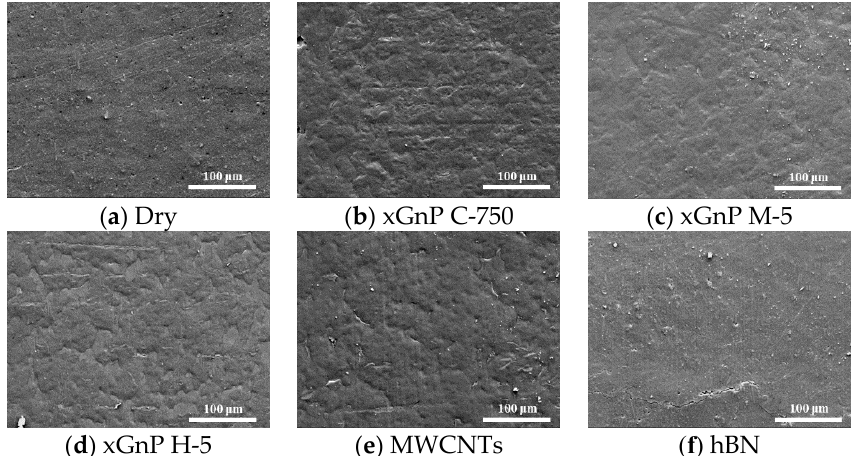
Figure 5. Optical microscopic images of MD-CFRP after the ball on plate test.